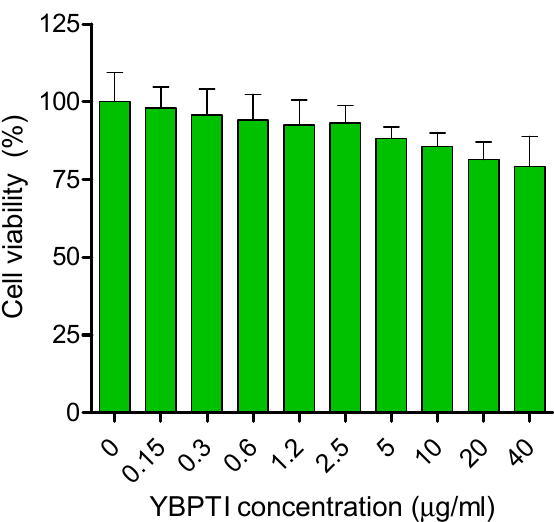
Figure 5. Effect of YBPTI on the α -glucosidase activity. YBPTI showed a concentration-dependent inhibition of α -glucosidase activity. Note that the derived IC50 value is 75.33 ± 1.17 ng/mL. 3.5. Cytotoxicity of YBPTI against HeLa Cells To evaluate the toxicity of YBPTI against human cells, in vitro cytotoxicity assays with HeLa cells was carried out, similarly to those described previously for other bioactive molecules [45,46]. These assays were performed using the range of concentrations where YBPTI inhibited the growth of Candida albicans in the range 0.15 µ g/mL to 40 µ g/mL. As shown in Figure 6, a value of around 5 µ g/mL would maintain almost 90% cell viability while a value of 40 µ g/mL would maintain close to 80% cell viability. Thus, the approxi- mated IC50 is certainly higher than 50 µ g/mL, a value almost 10-fold over the observed MIC determined against C. albicans .